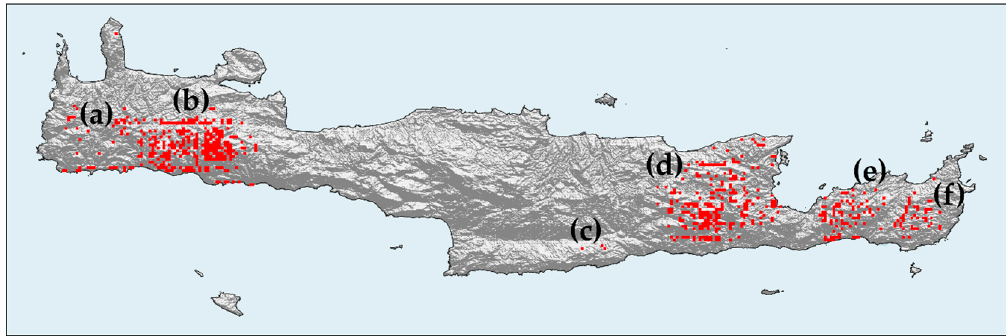
Figure 6. Red colour indicates areas identified as climatic refugia in Crete. ( a ) Western. ( b ) West (wider area of Lefka Ori). ( c ) Asterousia (located in south-central Crete). ( d ) East-Central. ( e ) East. ( f ) Eastern.